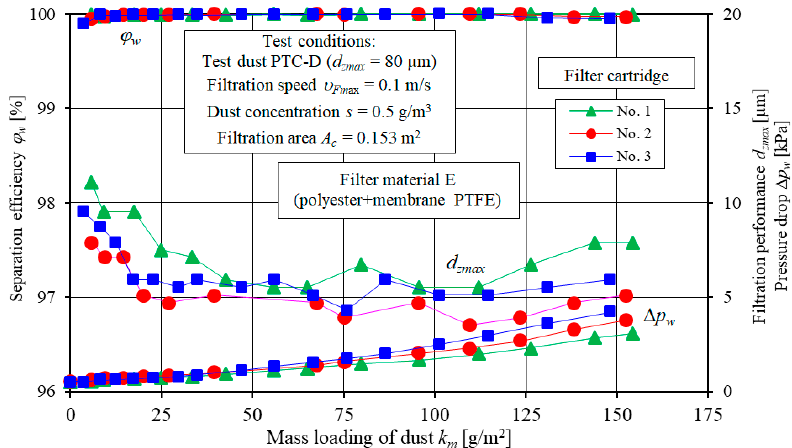
Figure 7. Separation efficiency φ w , filtration performance d zmax and pressure drop Δ p w as a function of dust mass loading k m for three filter elements E specimens.